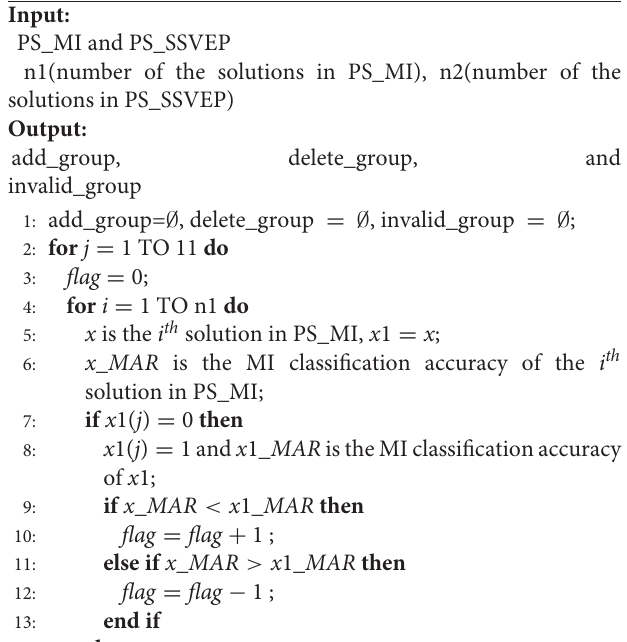
of the last four decision variables (lines 2–11 in Algorithm 3 ).